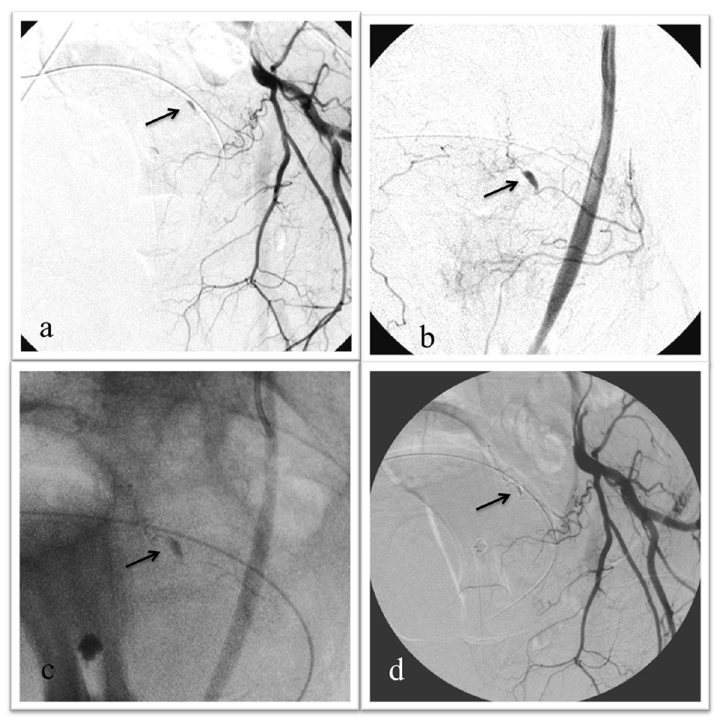
Fig. 2 a – d Selective left internal iliac artery angiography (IIA) in a patient suffering from pain and anemia after robotic prostatectomy shows the presence of a false aneurysm of the distal branch of the superior vescical artery ( a ). After superselective catheterization of the target vessel with a microcatheter ( b ), embolization is performed with Onyx 18. Filling of the pseudoaneurysmal sac, distal and proximal portion of the vescical artery is visible in c . IIA post-embolization angiography confirms effective occlusion of the target